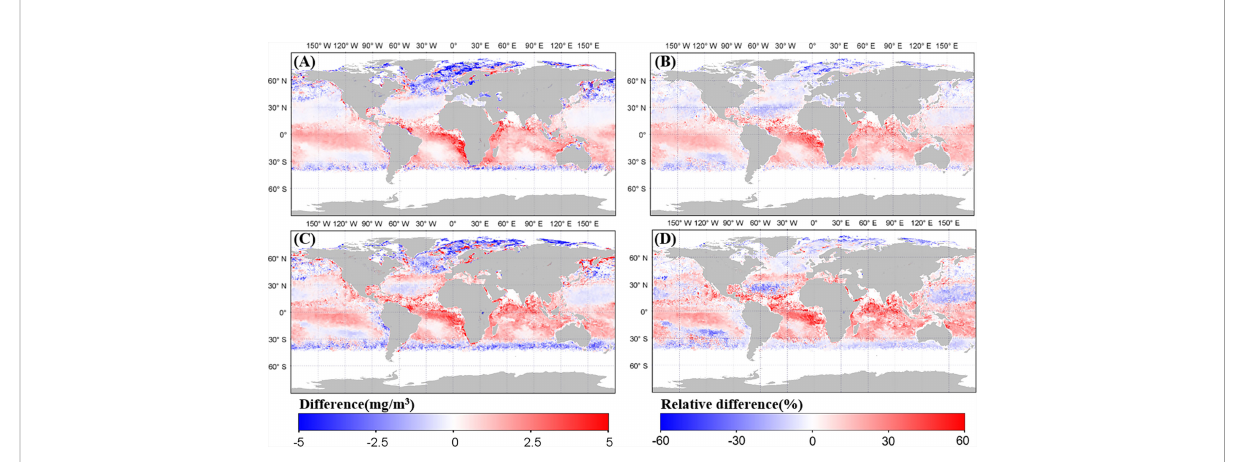
FIGURE 8 Absolute and relative PON concentration differences between models based on a (488) and the NDNI (A, B) , as well as that based on CHL and NDNI (C, D) . The left and right columns were for absolute and relative differences, respectively.